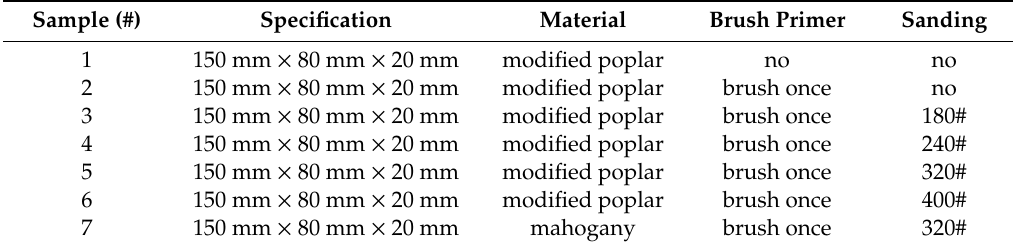
Table 1. Preparation of sample in pretreatment experiment